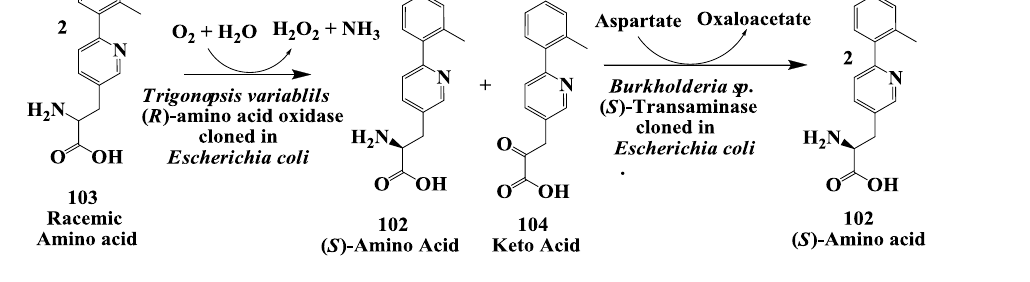
( S )-Amino-3-[3-{6-(2-methylphenyl)}pyridyl]-propionic acid was prepared by